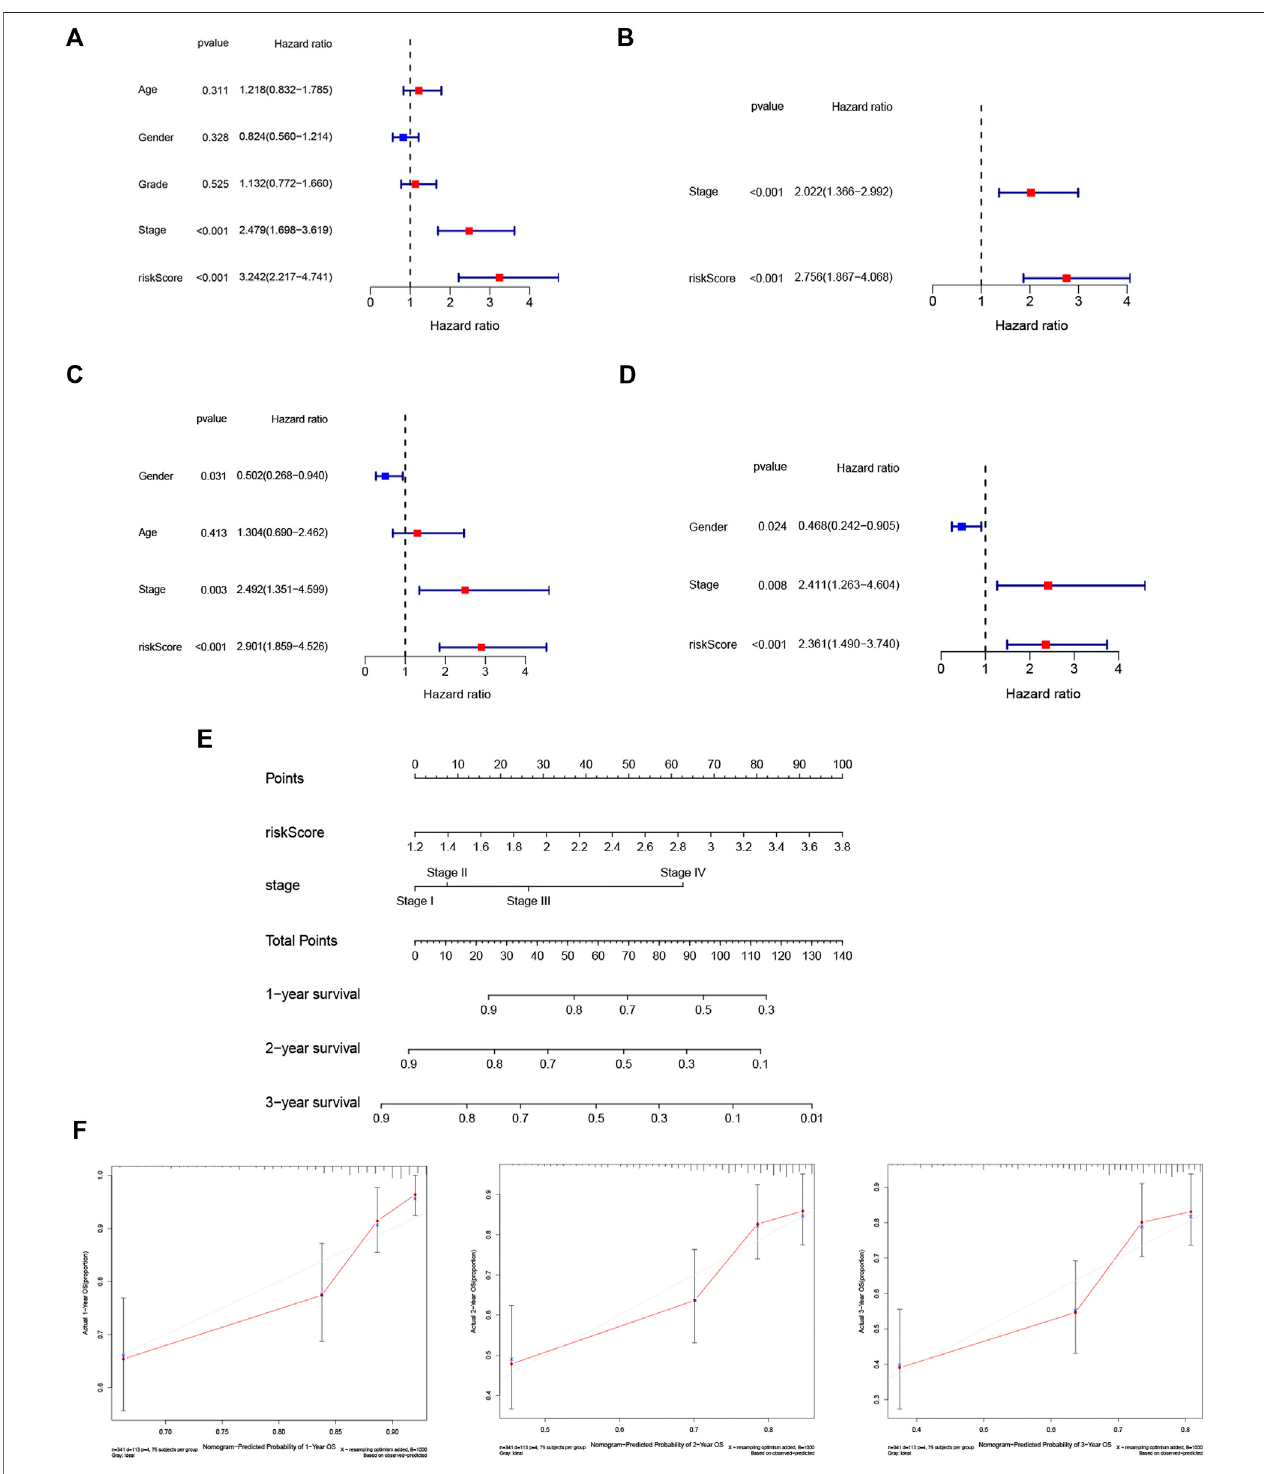
FIGURE 6 | Risk score is an independent prognostic signature for HCC and nomogram with calibration curves of the prognostic factor screened by multivariate Cox regression. Results of the univariate (A) and multivariate (B) Cox regression analyses of OS in the TCGA cohort. Univariate (C) and multivariate (D) Cox regression analyses of OS in the ICGC cohort. (E) Nomogram of the TCGA cohort. (F) Calibration curve of the TCGA cohort.